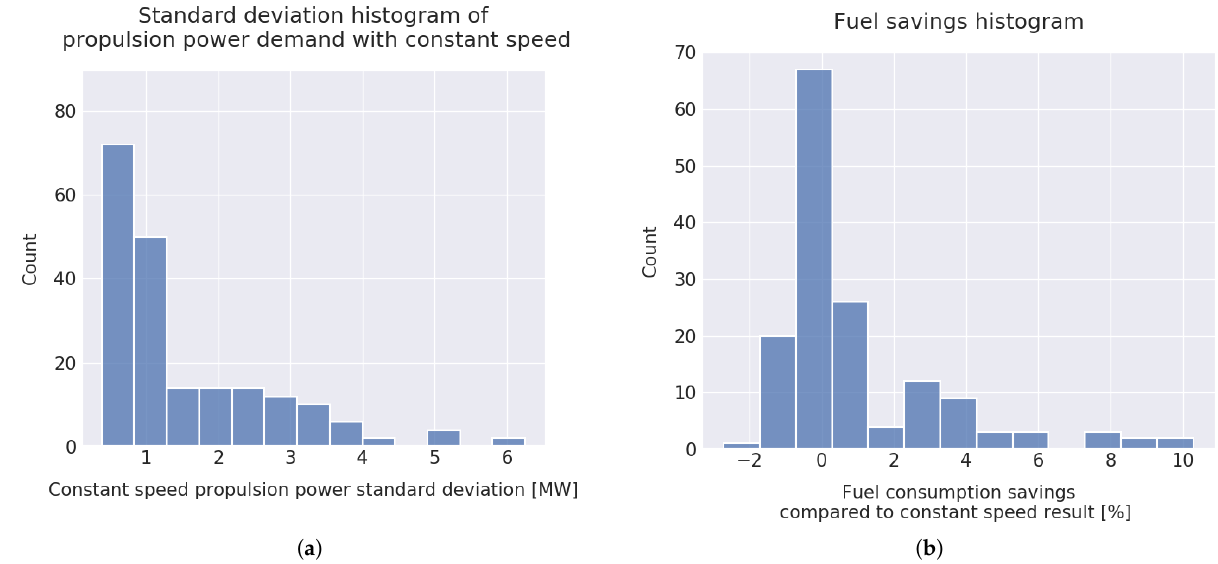
Figure 5. Histogram of propulsion power demand standard deviation with constant speed on all studied journeys ( a ) and attained fuel savings on all studied journeys, compared to fuel consumption with fixed speed ( b ).